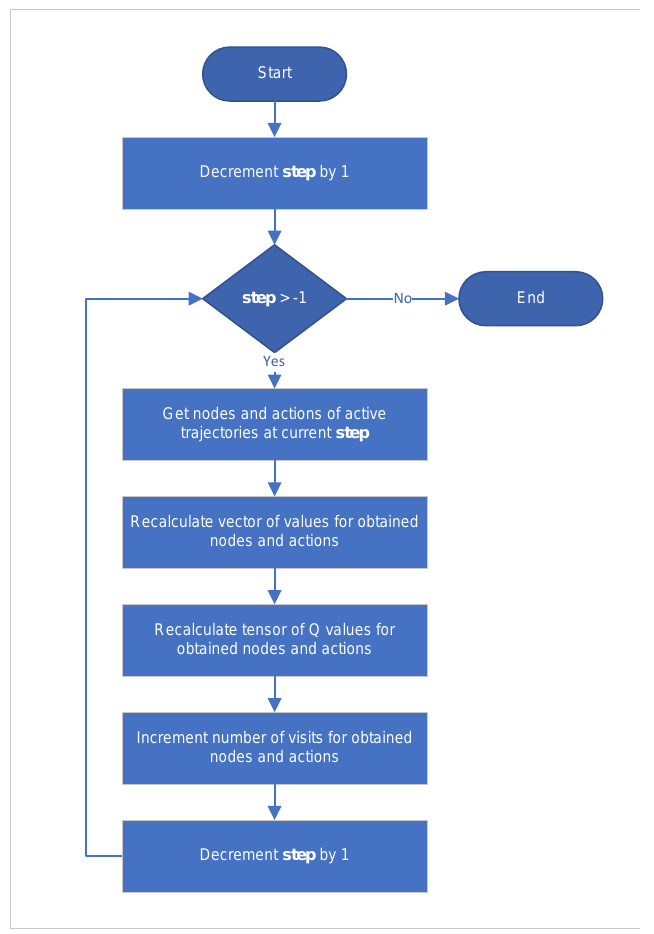
Figure 4. Flowchart of the phase of backpropagation. Algorithm 4 Phase of